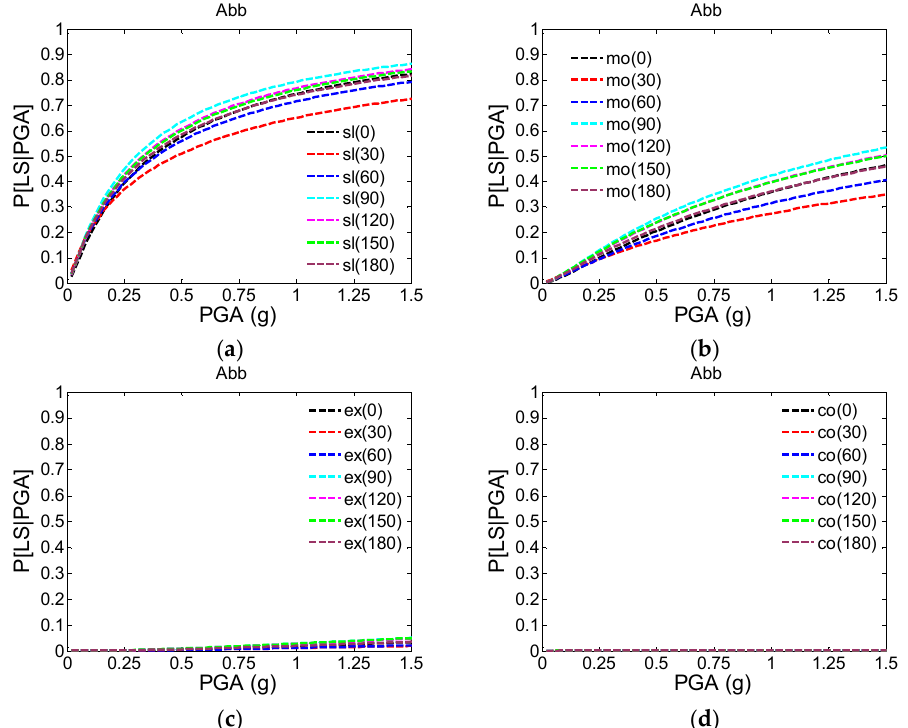
Figure 6. Seismic fragility curves of Abb subjected to different excitation angles in the ( a ) slight; ( b ) moderate; ( c ) extensive; and ( d ) complete limit states.